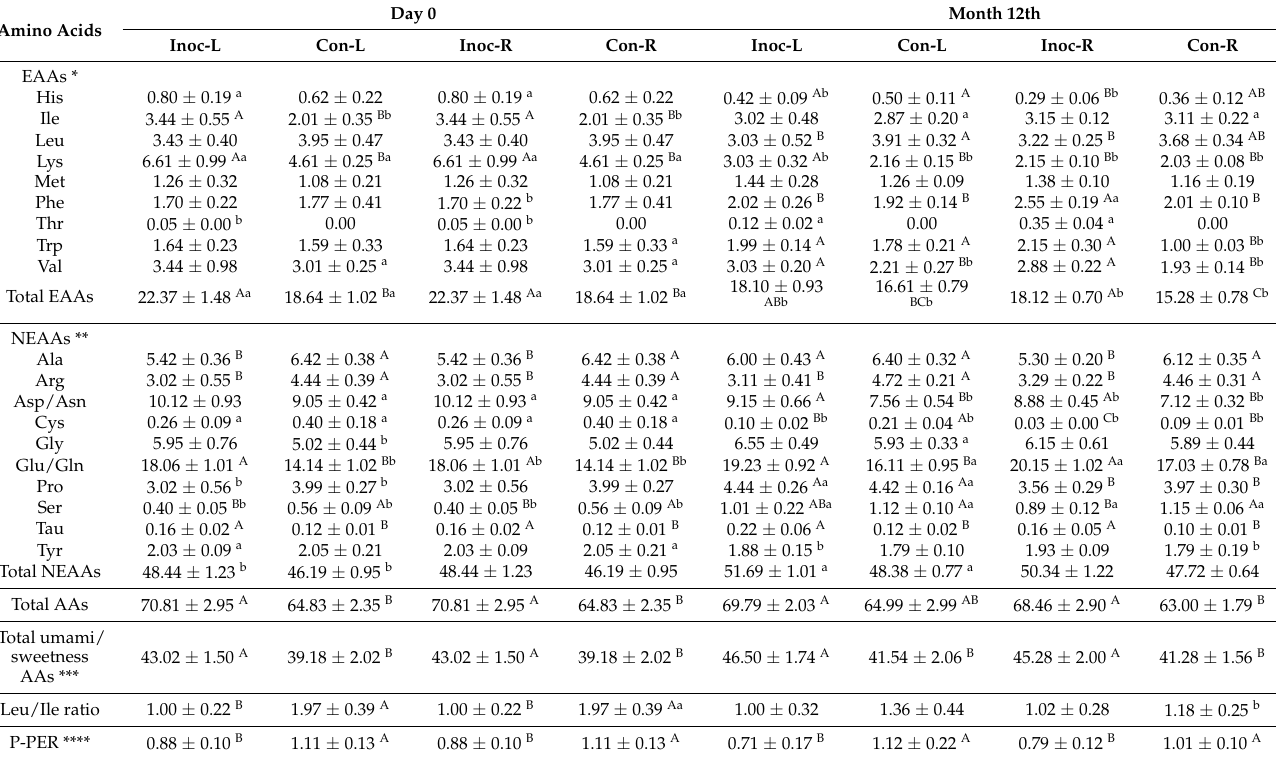
Table 2. Free amino acid contents (mg/g) of shrimp paste with/without B. subtilis K-C3 inoculation during 18 months of low (4 ◦ C) and room (28 ◦ C) temperature